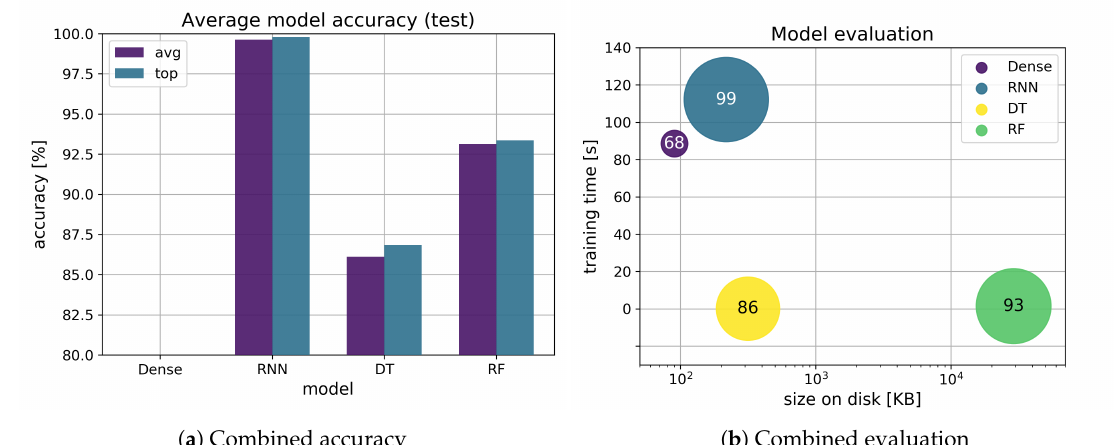
Figure 6. Evaluation overview.